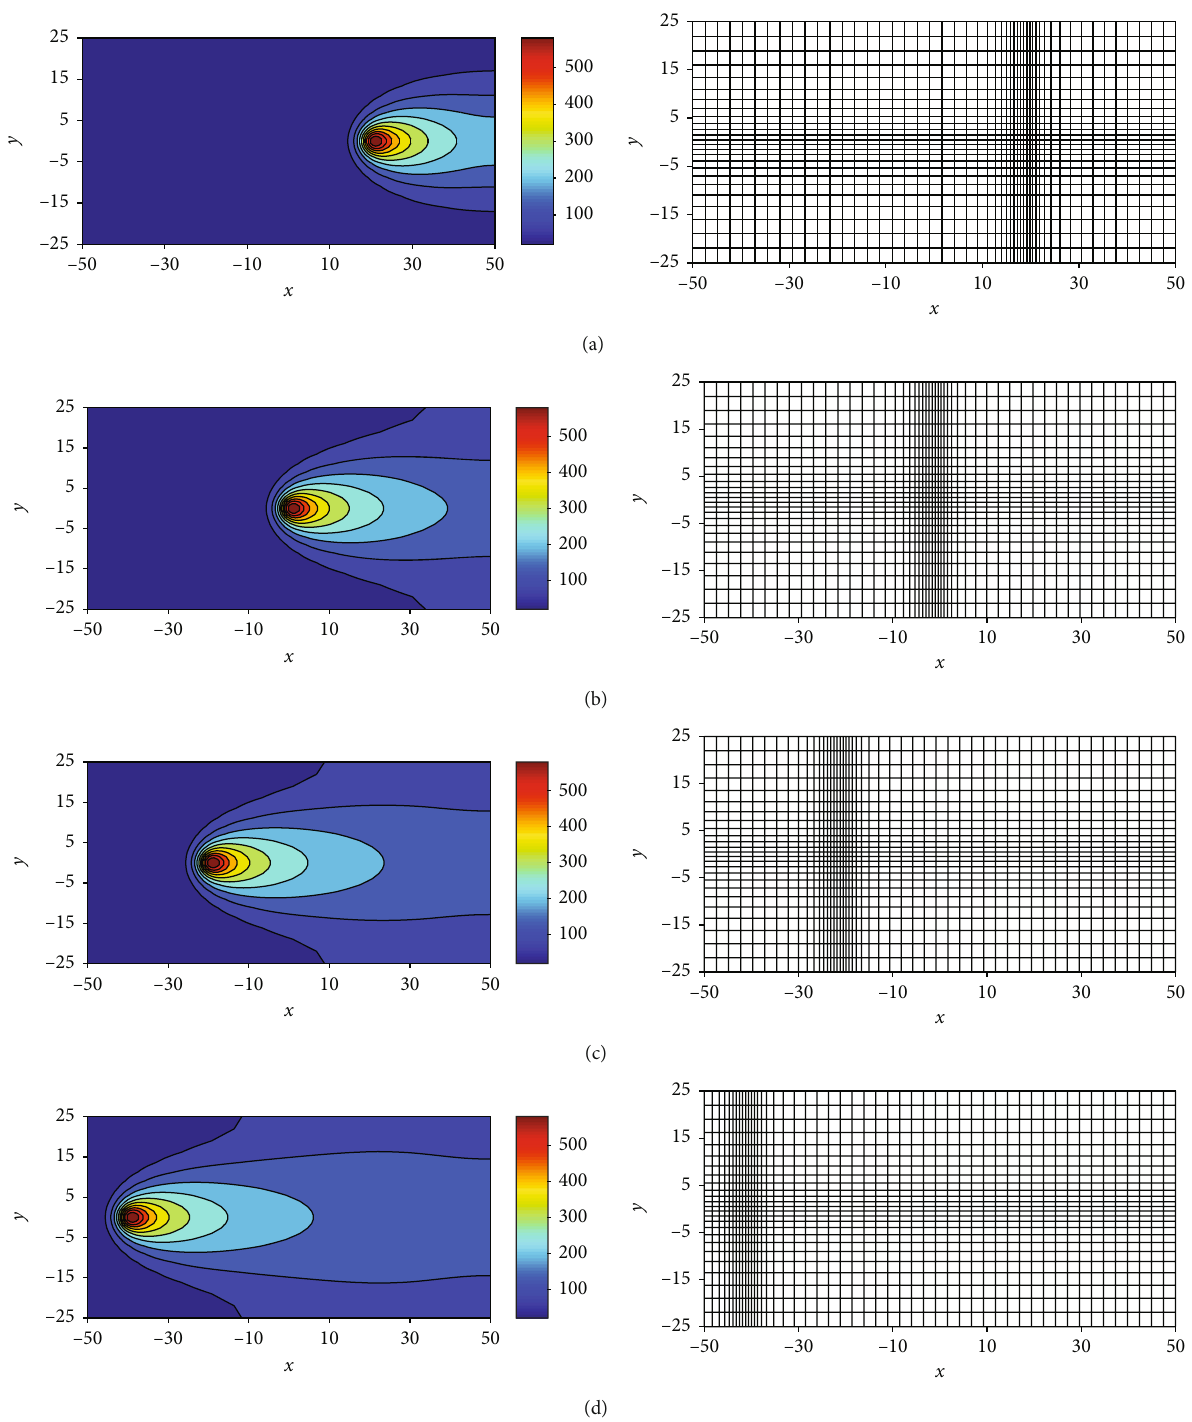
Figure 3: The transient temperature fi eld and the corresponding moving mesh at t = 15 (a), 25 , 35 , and 45 (d), respectively, for a single heat source moving along x -axis from right to